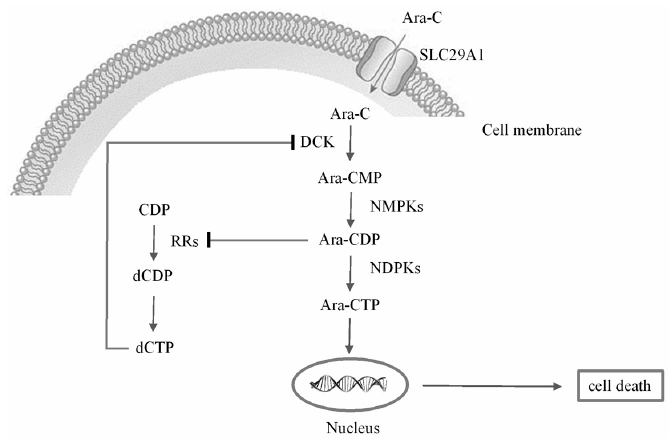
Figure 1. Schematic description of Ara-C transport and metabolism.